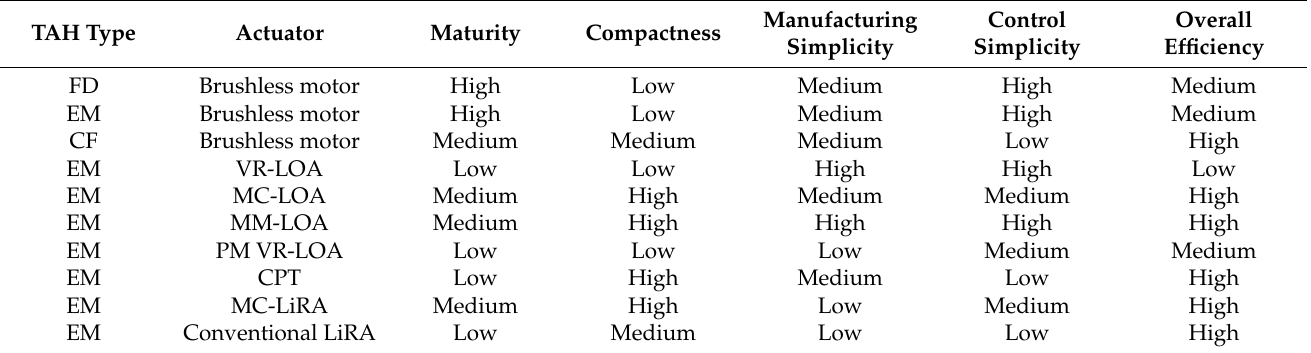
Table 2. Overall comparison of the main actuators for TAH